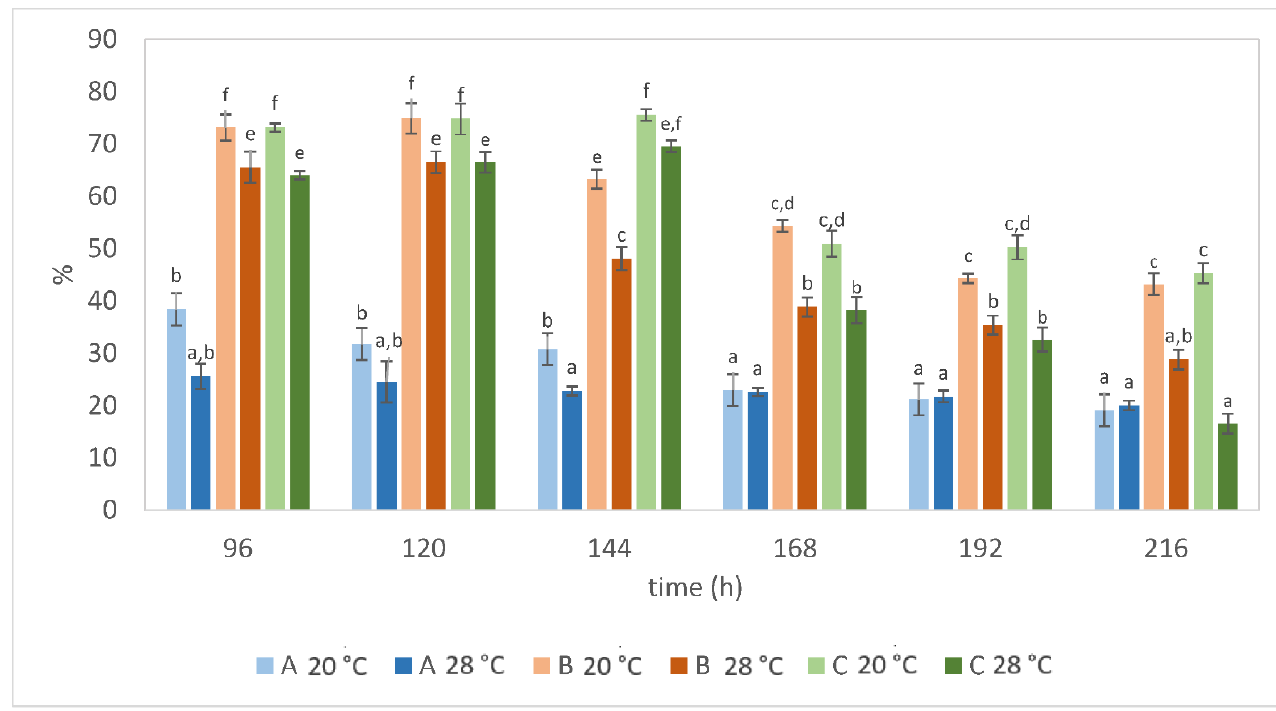
Figure 5. The efficiency of lipid production (ηL) as % of theoretical total lipid yield on the glucose (0.32 g g − 1 according to Papanikolaou and Aggelis, 2011). a – f Values with different superscripts within a column are significantly different at p < 0.05.